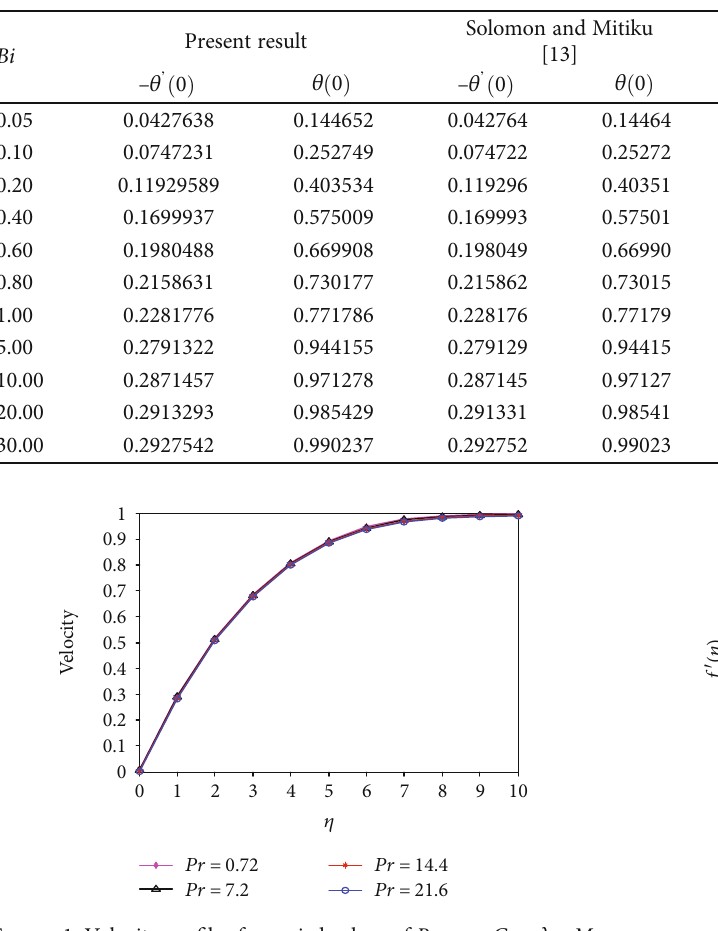
Table 2: Comparison of the results of the Nusselt number and surface temperature for di ff erent values of Bi with results reported by Solomon and Mitiku [13], Olanrewaju et al. [21], and Aziz [22].